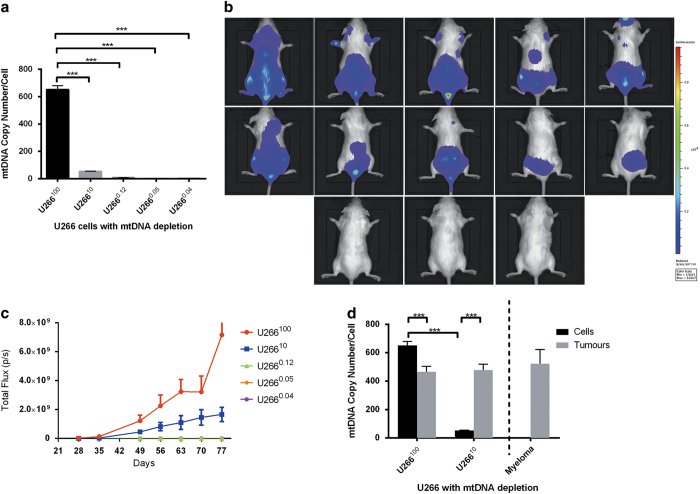
Undepleted and depleted U266 cells and tumour progression. (a) mtDNA copy number of U266 cells depleted to 10, 0.12, 0.05 and 0.04% of their original content; (b) in vivo tumour progression at day 49 (top row: U266100 tumours, second row: U26610, third row from left: U2660.12, U2660.05 and U2660.04); (c) tumour progression curve; and (d) mtDNA copy number in cells and tumours from U266100 and U26610 lines (***P<0.001).